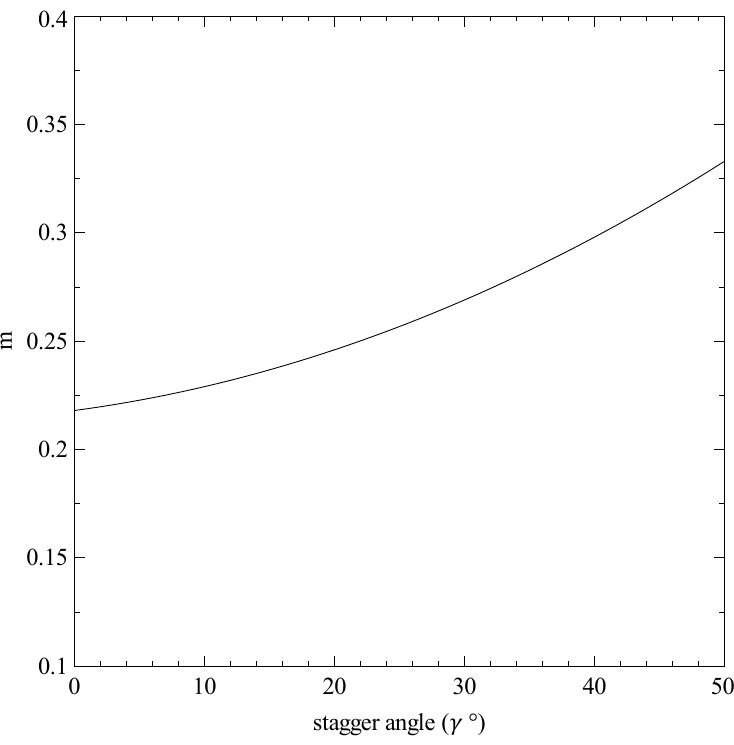
Figure 10. Deviation coefficient (m) as a function of the stagger angle ( γ ) [27].